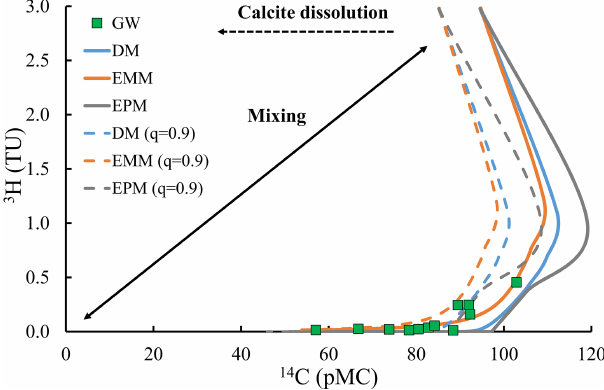
Figure 5. 3 H activities vs. 14 C activities of groundwater from the upper Wimmera River. Curved lines are the predicted covariance in the radioisotopes predicted by the exponential mixing, exponential piston (EPM ratio = 1), and dispersion (DP = 0.5) lumped param- eter models. Solid arrowed lines show schematically the effects of mixing between old regional groundwater (low 14 C and 3 H free) and modern or recently recharged water (high 14 C and 3 H). Cal- cite dissolution lowers the predicted 14 C activities (dashed lines are used to display 10% calcite